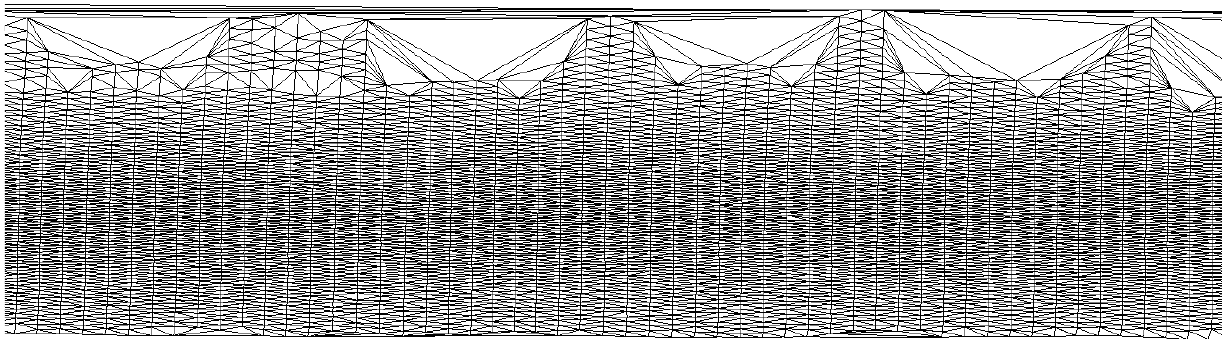
Figure 7. Part of the final road surface